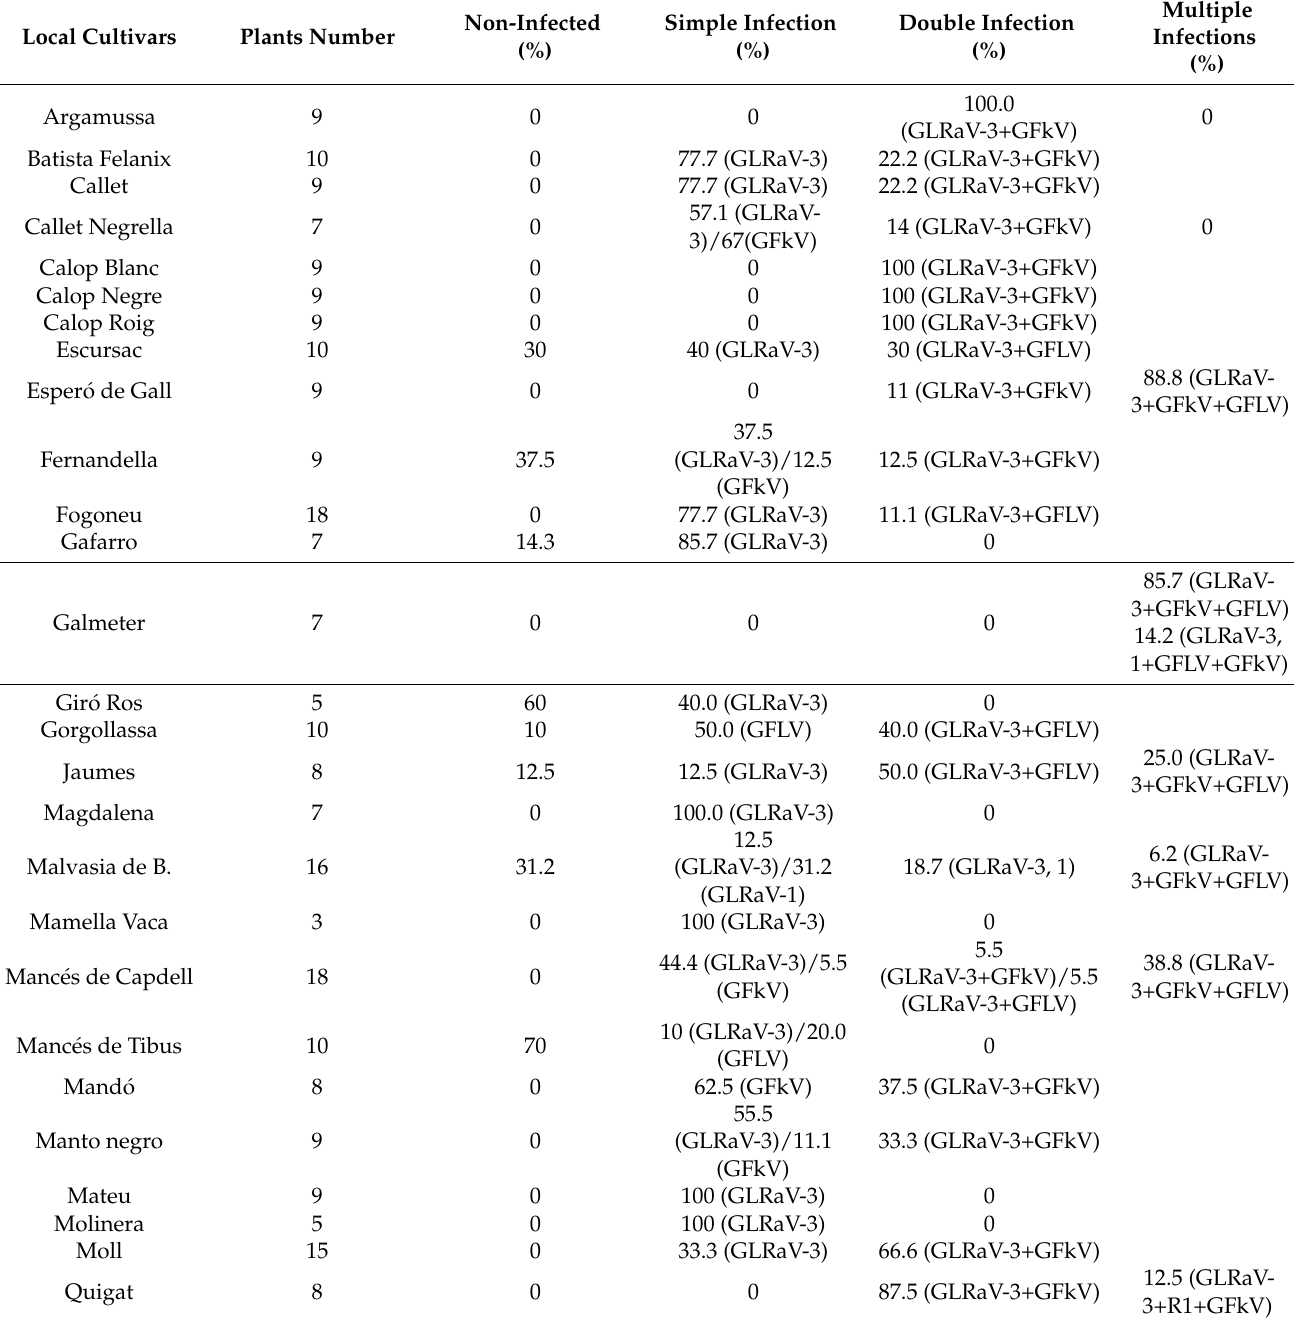
Table 2. Healthy plants (non-infected) and simple, double and multiple virus incidences per cultivar (% of total